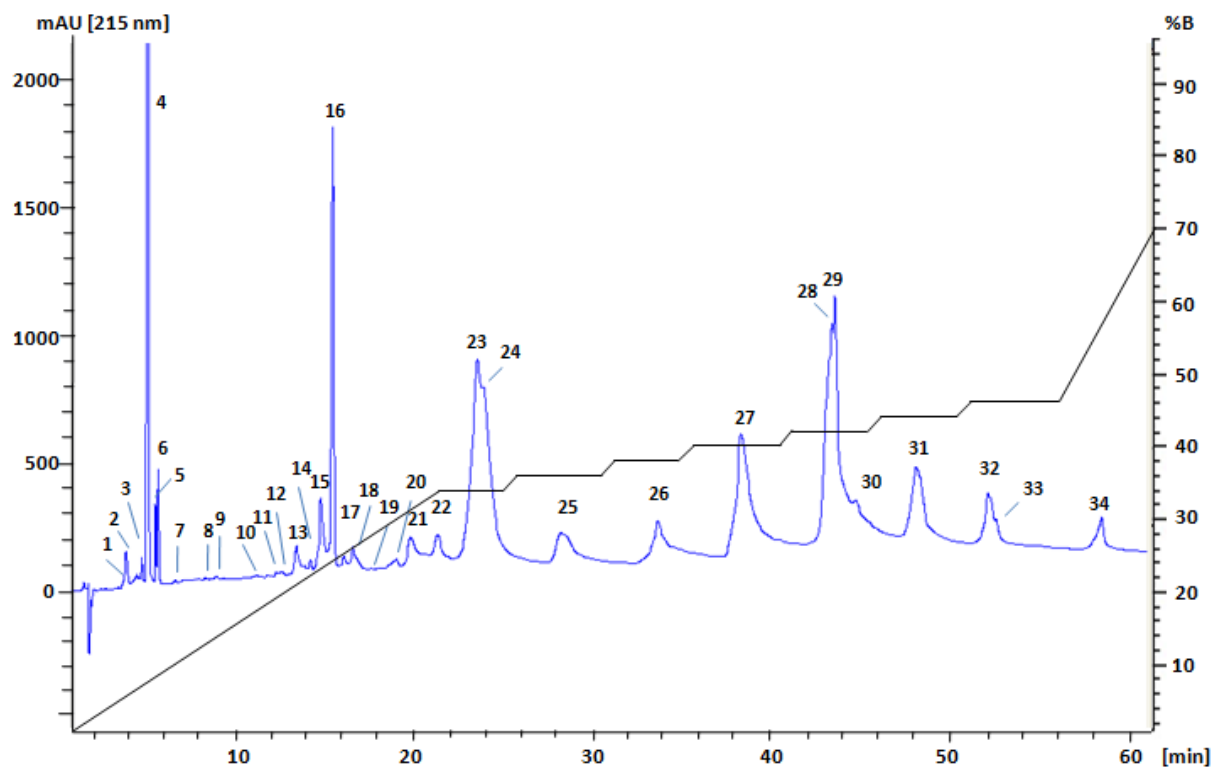
Figure 3. Reverse phase chromatographic separation of P. persicus venom. Lyophilized venom (10 mg) dissolved in 2 mL of double-distilled water was injected into C18 column continuously (100 µL of venom extract for each injection) and eluted using a semi-step gradient of acetonitrile/0.1% TFA (%B). Thirty-four protein fractions according to their peak distribution were collected manually, lyophilized and used for further